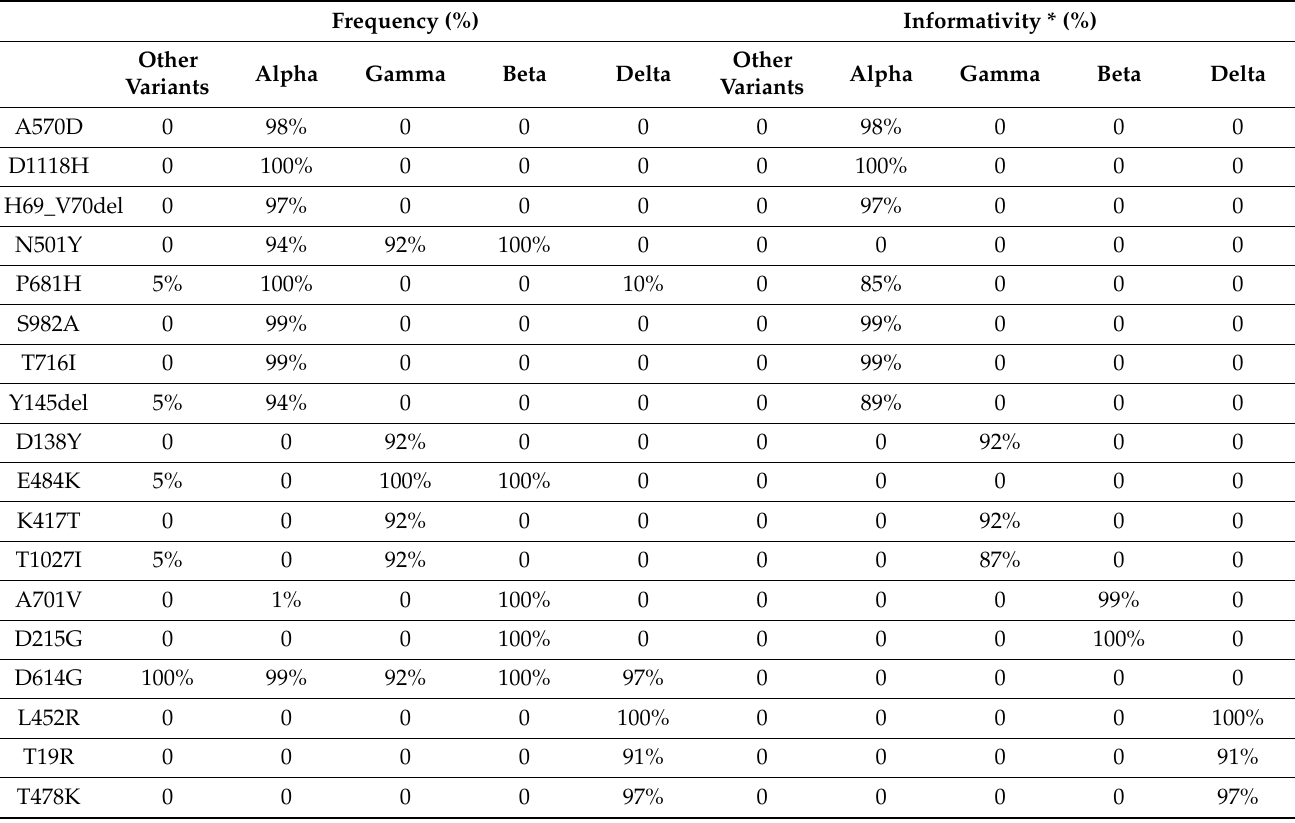
Table 4. Frequency and informativity of 18 selected SNPs in 132 SARS-CoV-2 genomes. Frequency (%) Informativity *